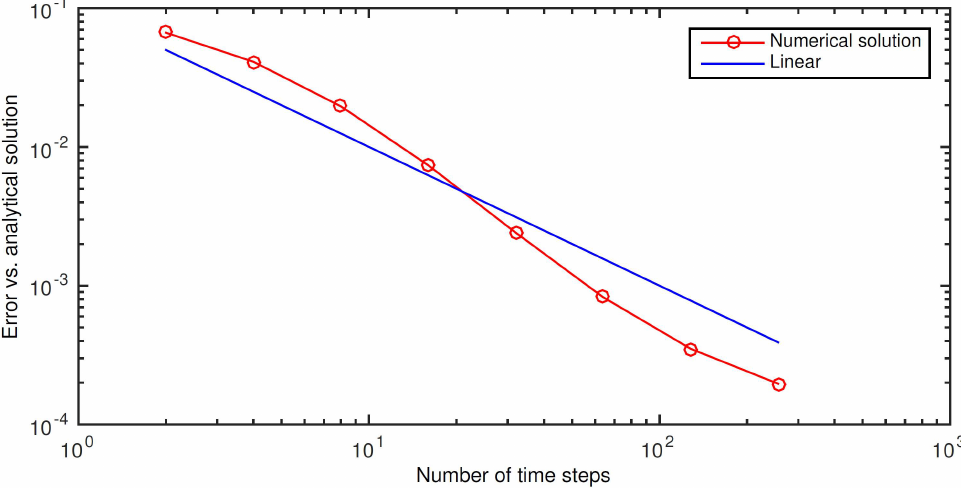
Figure 3. Convergence as τ → 0. We note that the convergence appears to be